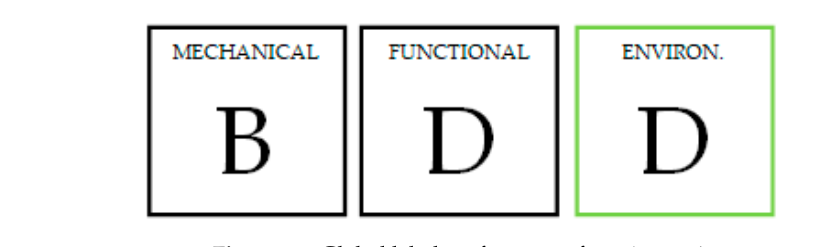
Figure 25. Global label performance for mixture 1. Appl. Sci. 2019 , 9 , 1694